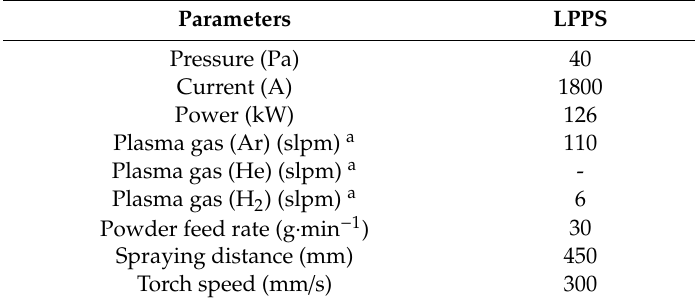
Table 2. Deposition parameters of NiCoCrAlY coating prepared by low pressure plasma spraying. Parameters